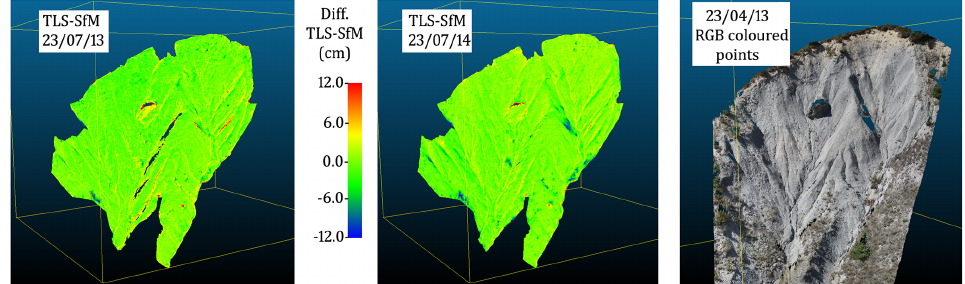
Figure 9. Comparison of DEMs between techniques, considering TLS as the reference, on north-facing slopes. Differences have been calculated for the first and last acquisition dates (23 July 2013 and 23 July 2014) (cloud compare software). A RGB coloured points image is added in the right panel as an overview of the north-facing slopes